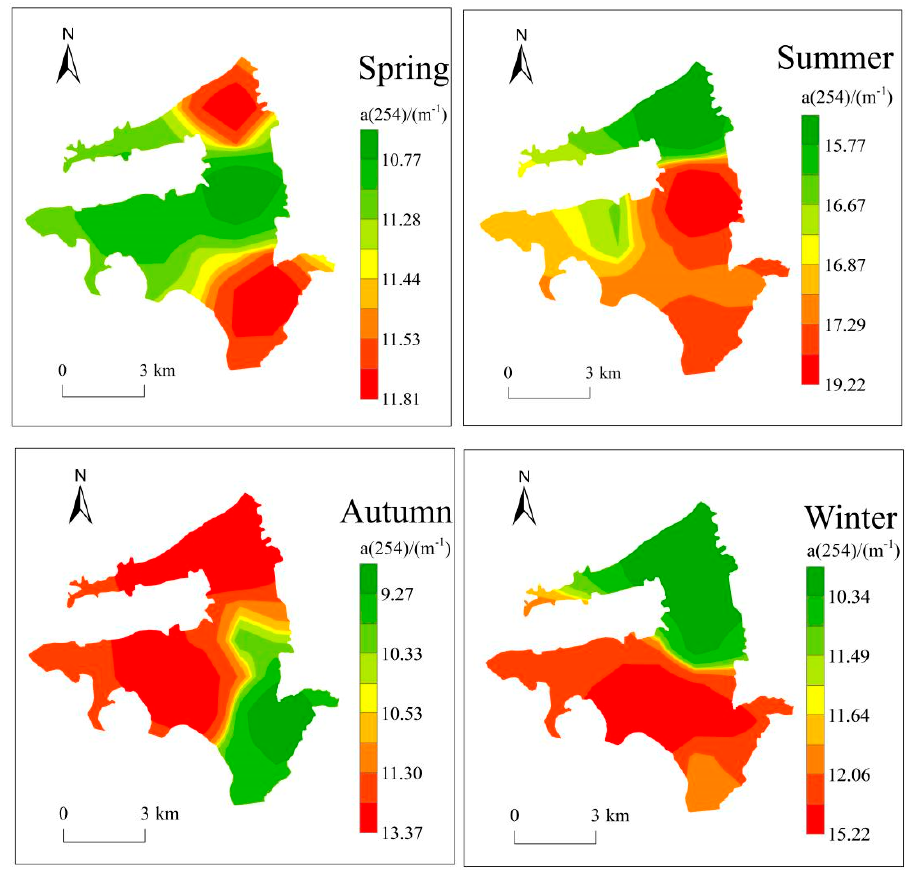
Figure 3. Spatial–temporal trends of a(254) in Bao’an Lake by season.